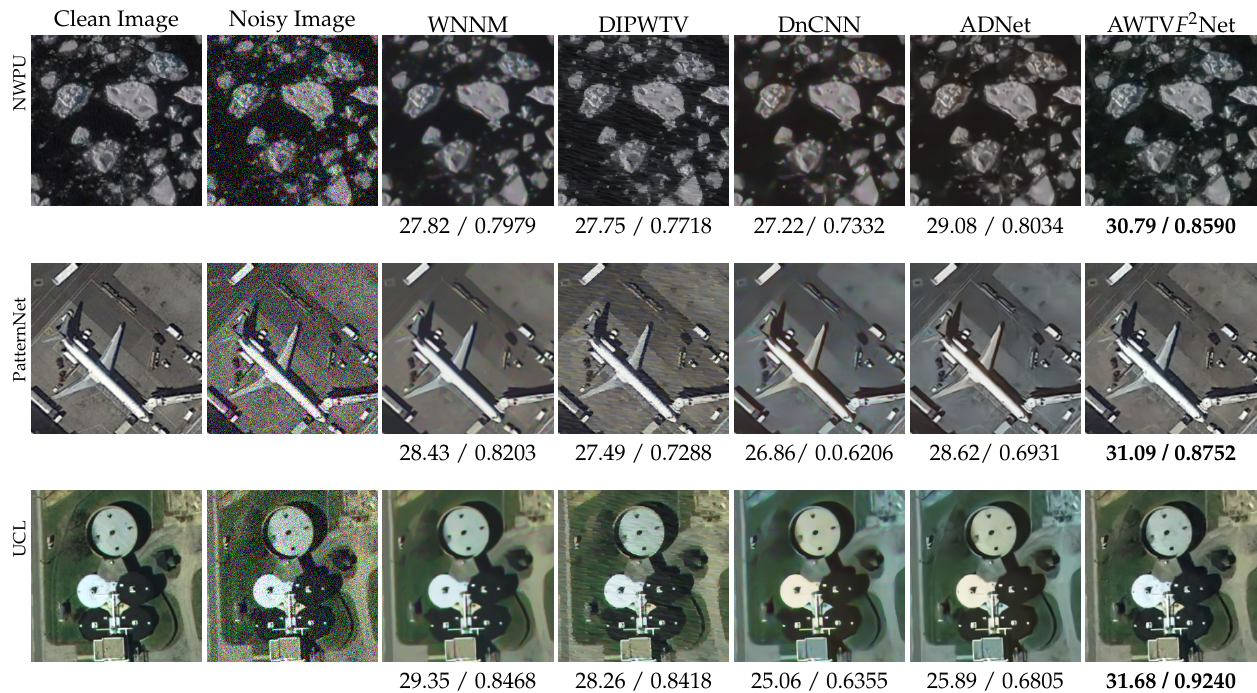
Figure 10. Restored results on NWPU, PatternNet and UCL datasets with noise level σ 2 =